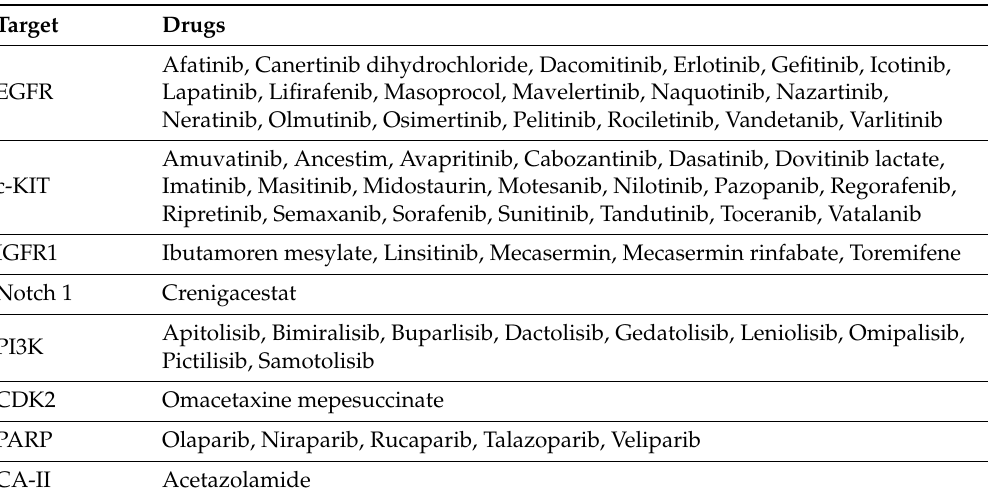
Table 5. Known drugs against the selected drug